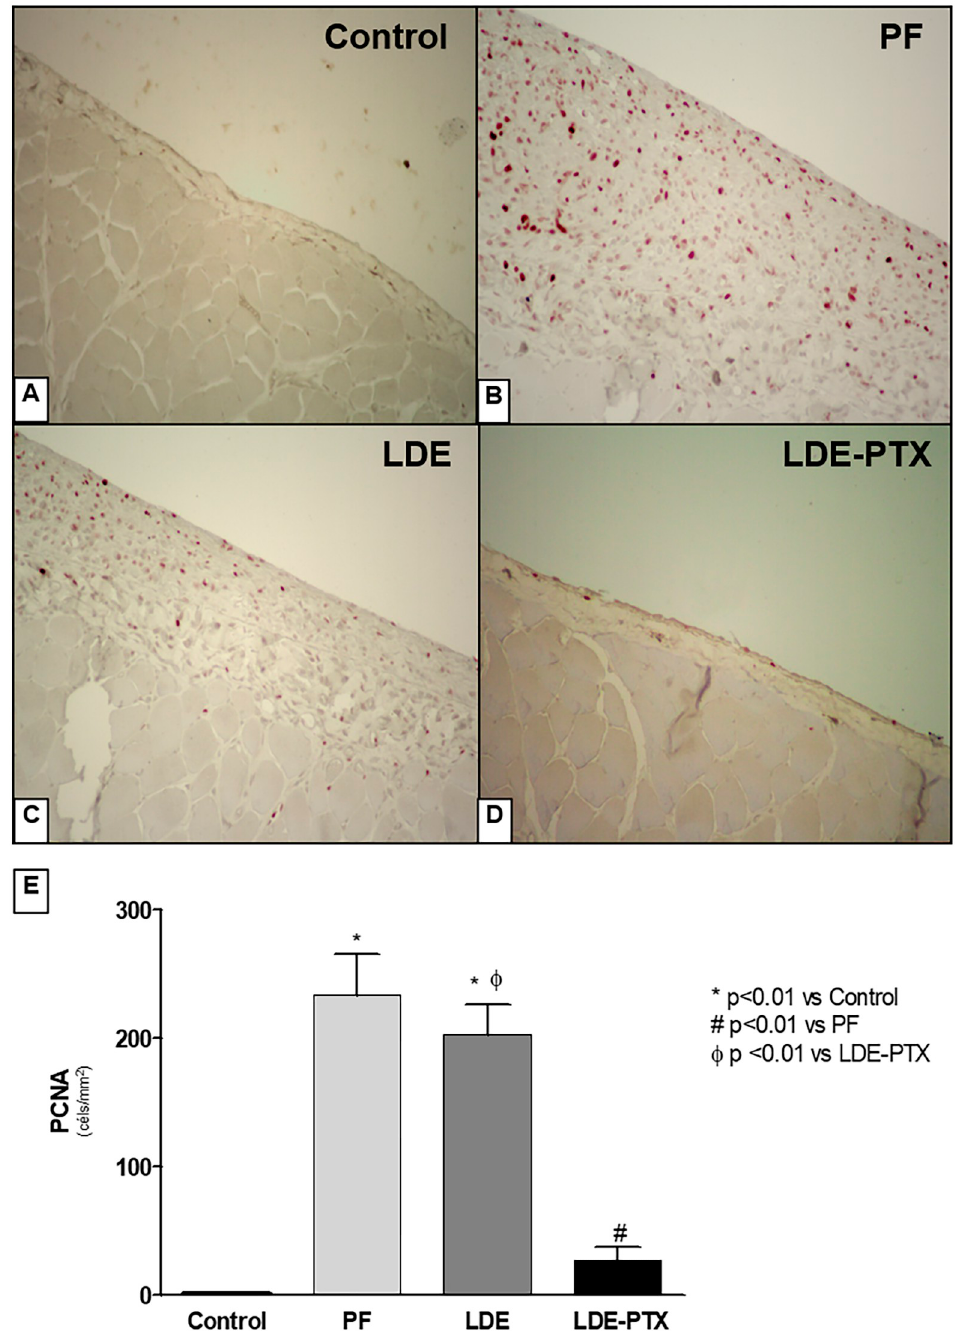
Fig 4. LDE-PXT treatment on proliferation. Representative photomicrographs of peritoneal membrane samples stained for anti-proliferation cell nuclear antigen (PCNA) using immunohistochemistry (x200). (A) The Control group (n = 5) showed no expression of PCNA. (B) The PF (n = 5) and (C) the LDE groups (n = 8) showed a significant increase of PCNA expression. (D) LDE-PXT group (n = 8) exhibited a significant reduction of PCNA expression demonstrated by quantitative analysis (E) . � p < 0.01 vs Control; # p < 0.01 vs PF; F p < 0.01 vs LDE-PTX.